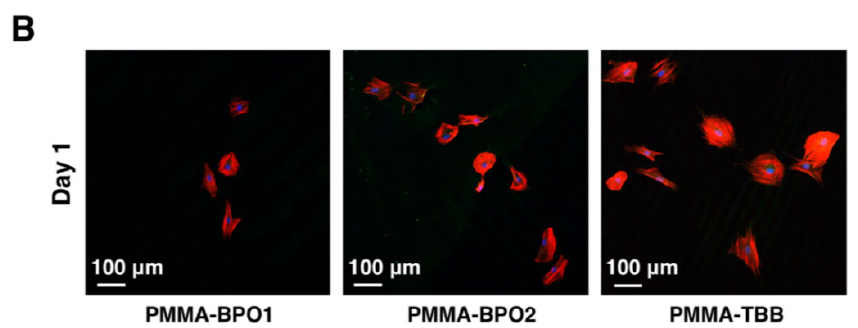
Figure 1. Initial osteoblast attachment to culture wells after 24 h of culture with three different bone cement extracts. ( A ) The number of cells attached to the culture wells after one day of culture was evaluated by manually counting cells using a hemocytometer. Data shown are mean ± SD ( n = 3). Significant differences between the three groups are shown (one-way ANOVA followed by Bonferroni correction, * p < 0.05. ( B ) Representative fluorescence microscopy images of initially attaching osteoblasts after 24 h of culture stained with rhodamine phalloidin for actin filaments (red) and 4′,6-diamidino-2-phenylindole (DAPI) for nuclei (blue) at low magnification.